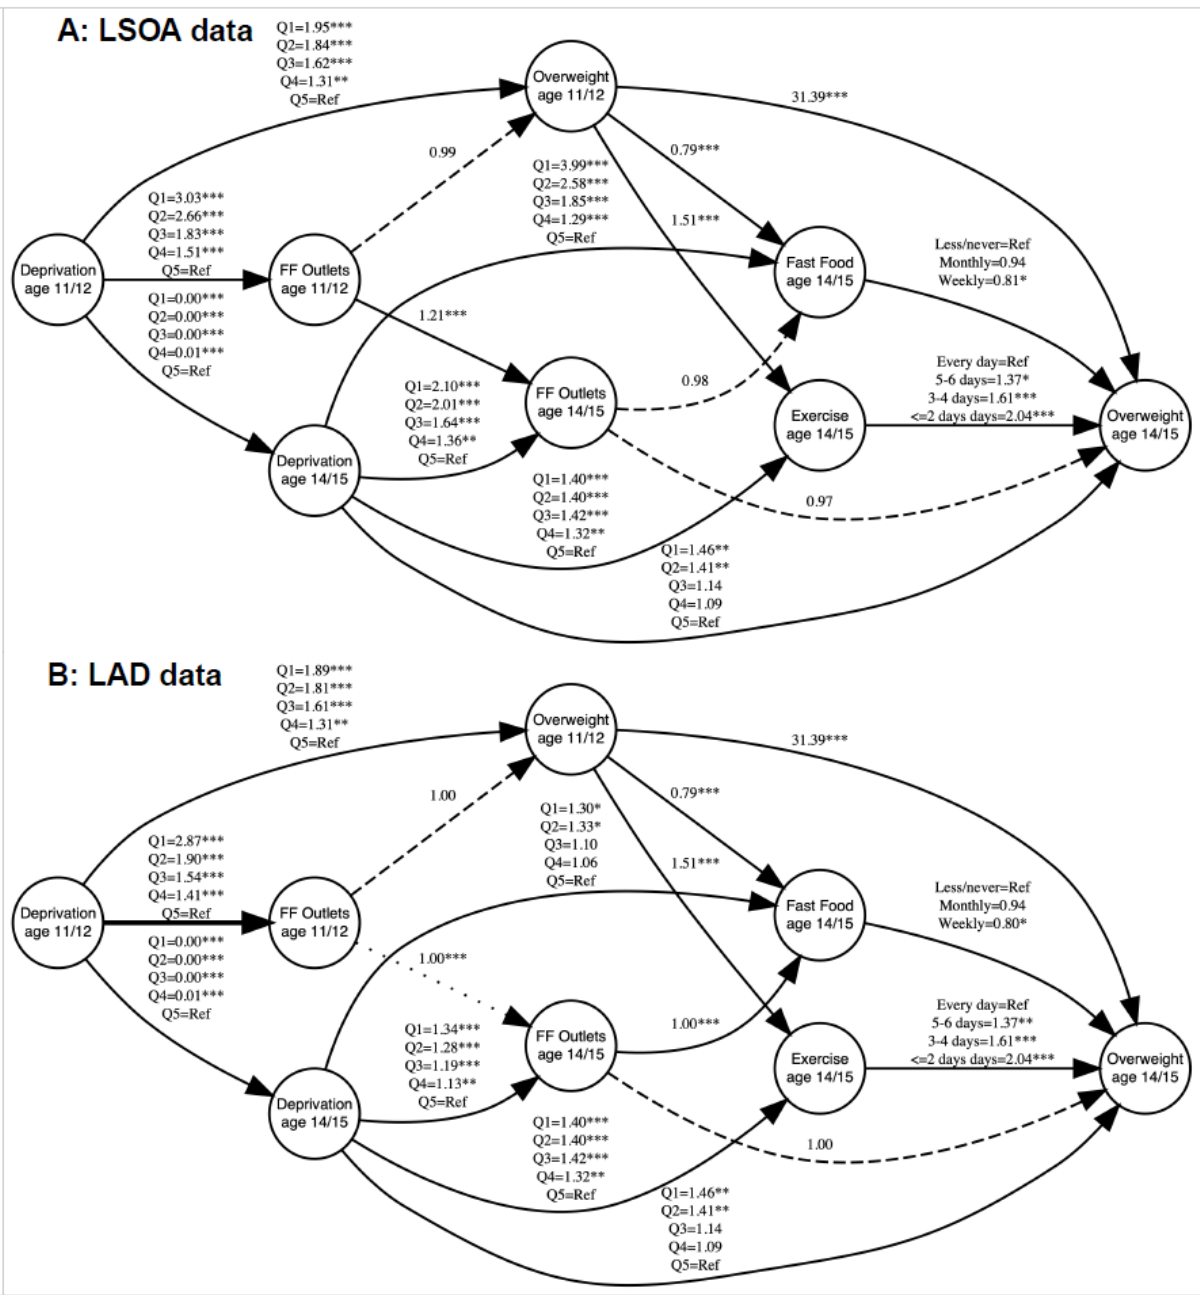
Figure 2. Two Structural Equation Models exploring whether the association between density of takeaways and overweight in children persists after account for fast food consumption and physical activity. (Error terms are not presented to aid visual interpretation. The full outputs for models can be seen in the Supplementary material in Tables S7 and S8. Dotted lines represent insignificant associations, hard lines represent significant associations. * p < 0.05, ** p < 0.01, *** p < 0.001. LSOA = Lower Super Output Area. LAD = Local Authority District).